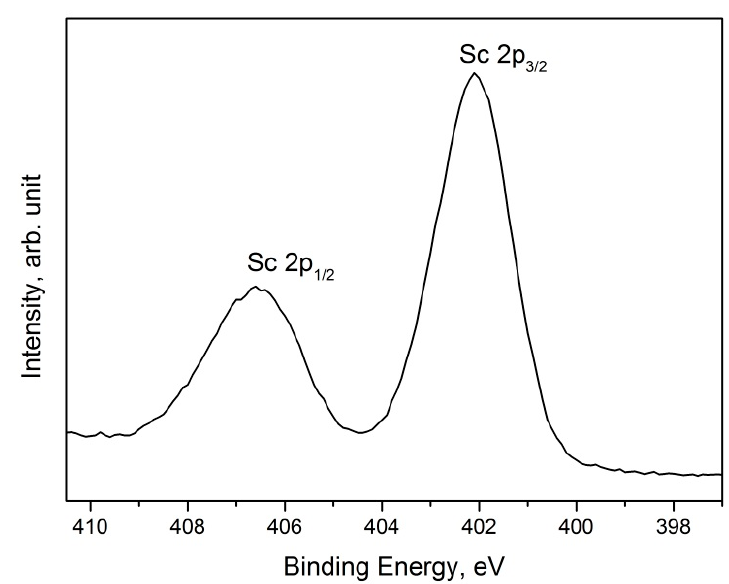
Figure 2. Sc 2p spectrum composed of a typical doublet Sc2p 3/2 –Sc2p 1/2 .